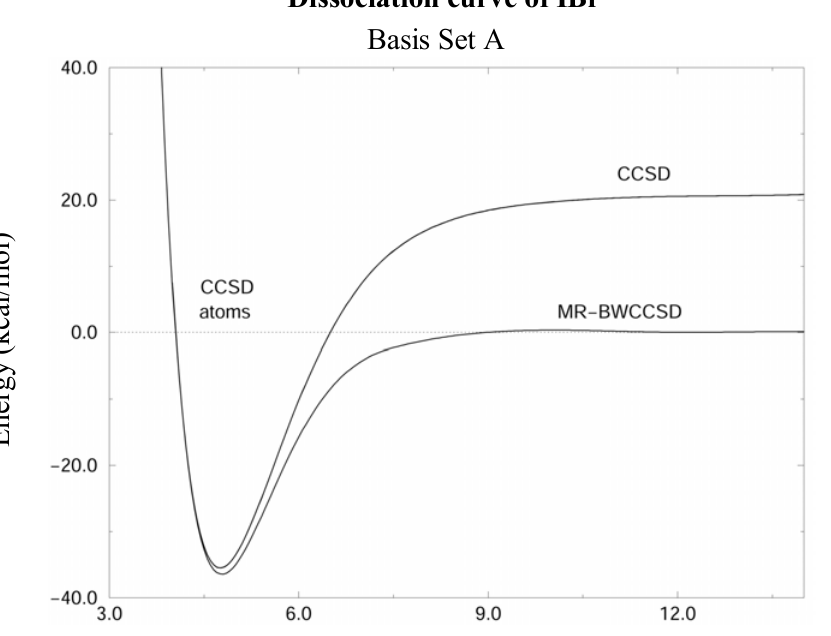
Figure 1. Potential energy curves of the IBr molecule calculated by the CCSD and MR-BWCCSD methods in the basis set A (see text) shown by solid lines. Energy scale is relative to the sum of energies of isolated atoms, which is indicated by the dashed line. Notice the incorrect dissociation limit of the single-reference CCSD.